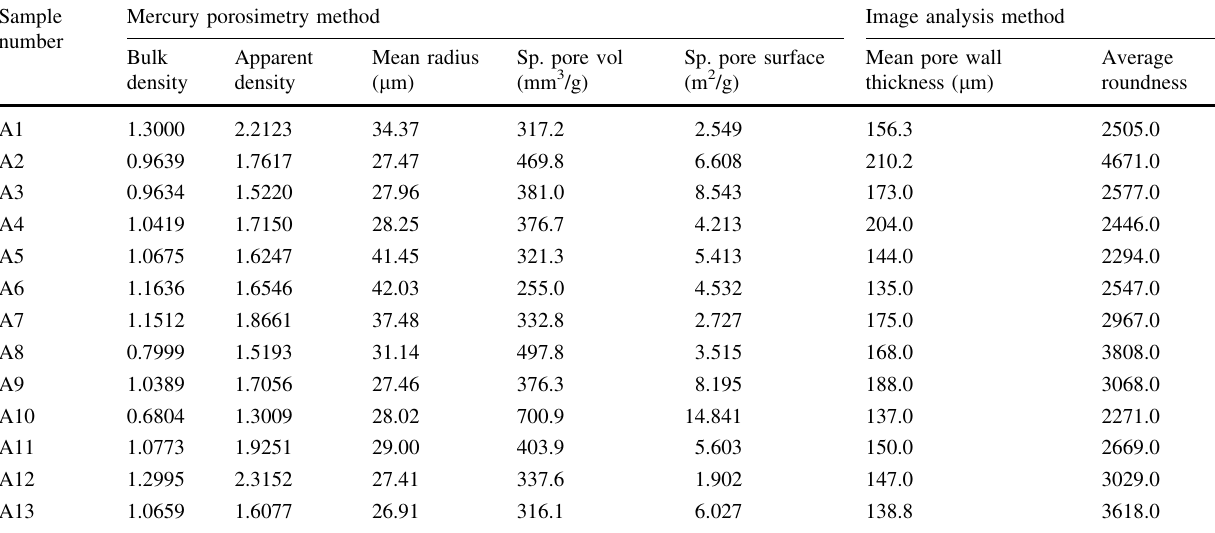
Table 6 Comparison of pore structures analysis by different methods Sample